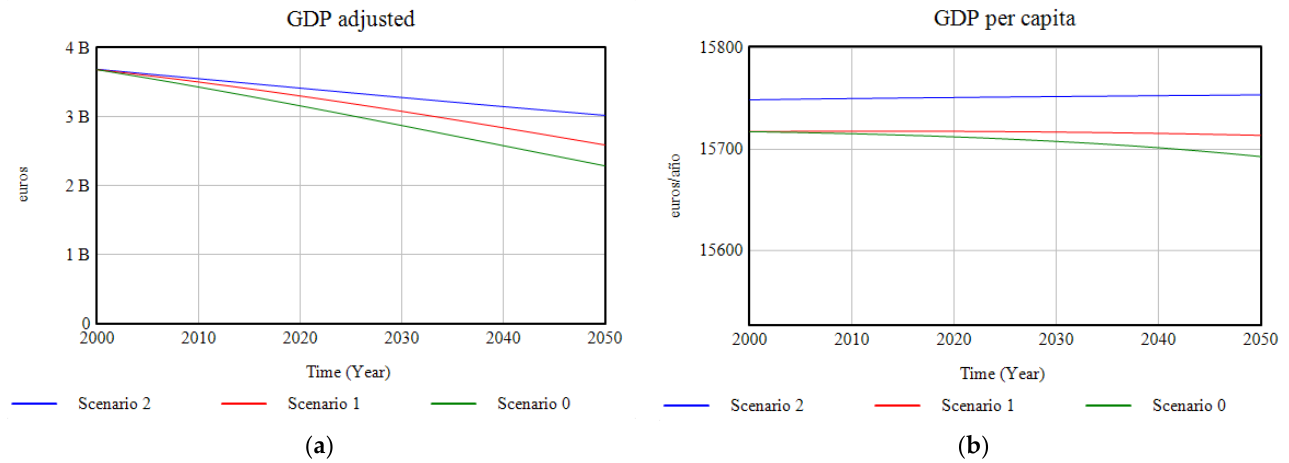
Figure 14. ( a ) Graphic results of the modelling of the adjusted GDP; ( b ) results of the modelling of the GDP per capita, in the period 2000–2050.